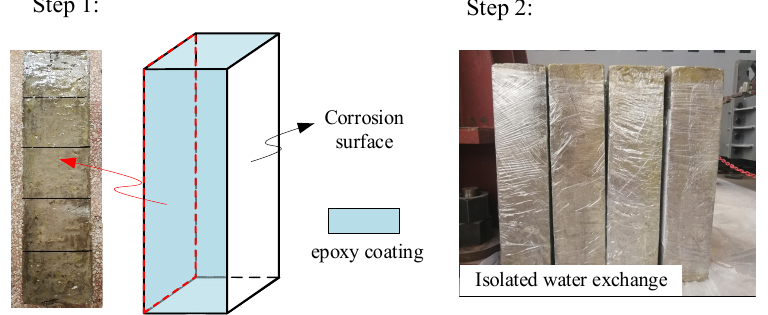
Figure 1. The specimen preparation process.